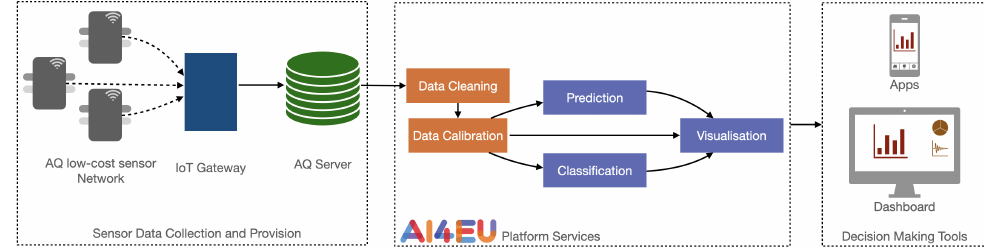
Figure 1. Overview of data collection, process and application